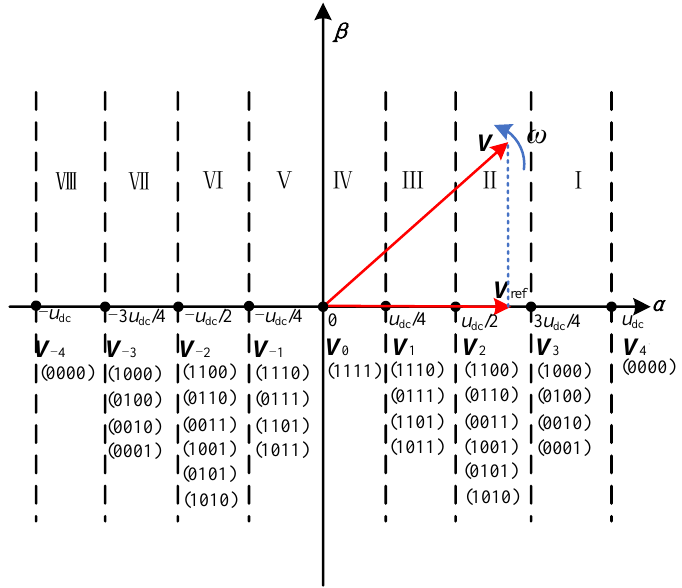
Figure 3. Space vector diagram for the single-phase five-level rectifier. As shown in Figure 3, V is a virtual vector with angular velocity ω rotating counter- clockwise. The projection on the α axis of V is the output reference voltage vector V ref of the rectifier. Considering the different input current directions at the AC side, the single-phase five-level rectifier has a total of thirty-one space voltage vectors. Except for the zero vector (1111), each switching state corresponds to two voltage vectors with different directions and the same length. vectors. V 3 and V − 3 are medium-long vectors, in which (1000), (0100), (0010) and (0001) are redundant vectors. V 2 and V − 2 are medium vectors, in which (1100), (0110), (0011), (1001), (0101) and (1010) are redundant vectors. V 1 and V − 1 are short vectors, in which (1110), (0111), (1101) and (1011) are redundant vectors. V 0 is a zero vector. Before selecting the basis synthetic voltage vector, the sector to which the reference selection of the basis synthetic voltage vector are as follows: